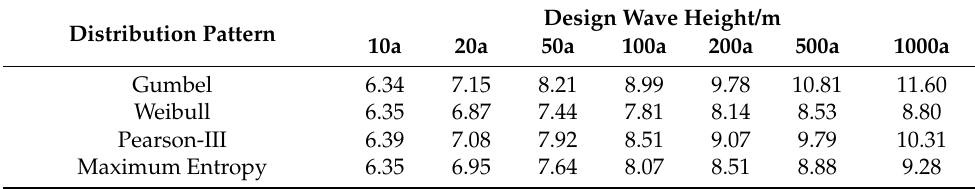
Table 5. Statistical analysis results of annual extreme value method.